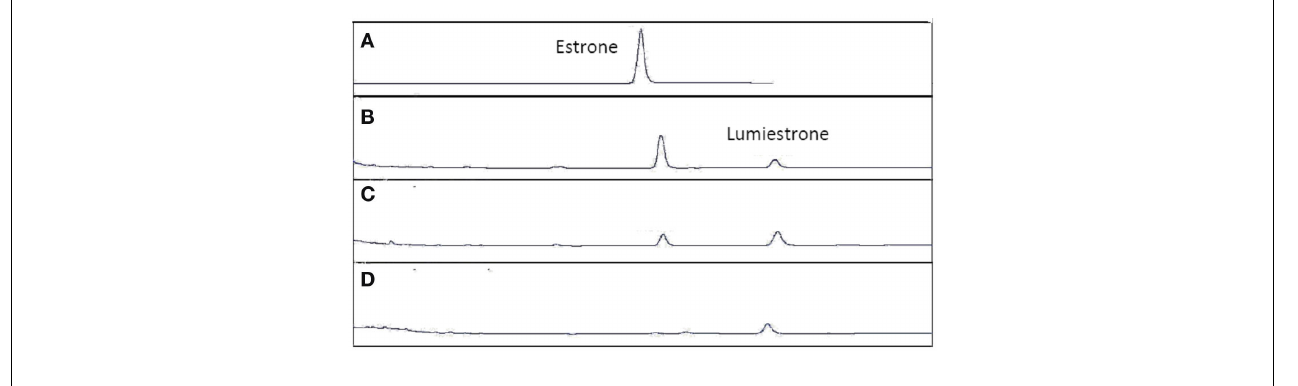
conditions (H 2 O/CH 3 CN 1:1) was performed on an Agilent 1100 Binary HPLC pumps system equipped with a UV-detector.The column used was